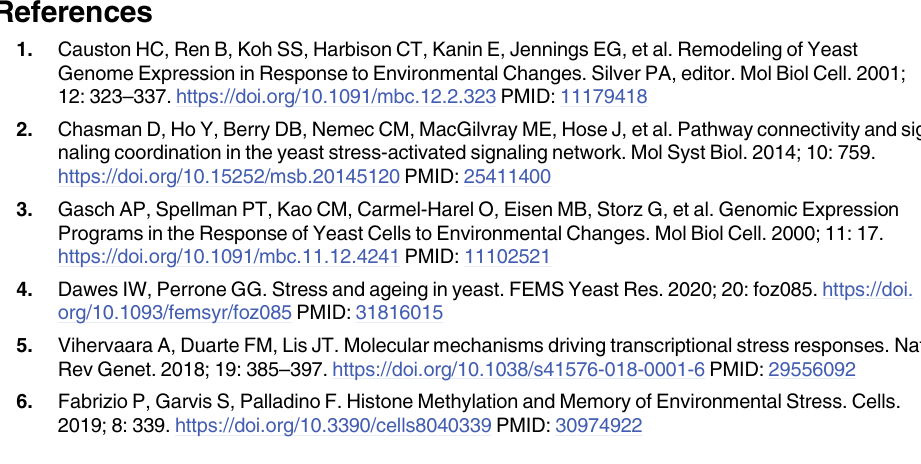
S5 Table. IDP KEGG enrichment using clusterProfiler including the stress pathways. S6 Table. Distribution of IDTFs in stress response pathways. S7 Table. Yeast IDPs involved in osmotic stress response. S8 Table. Yeast IDPs involved in heat shock stress response.